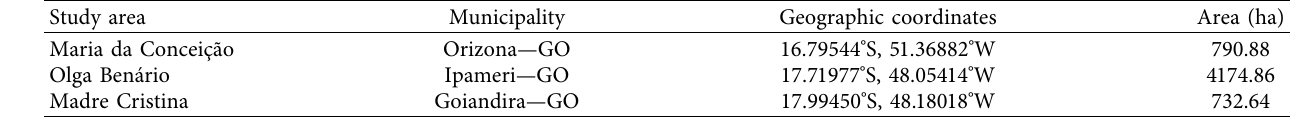
Table 1: Description of the study